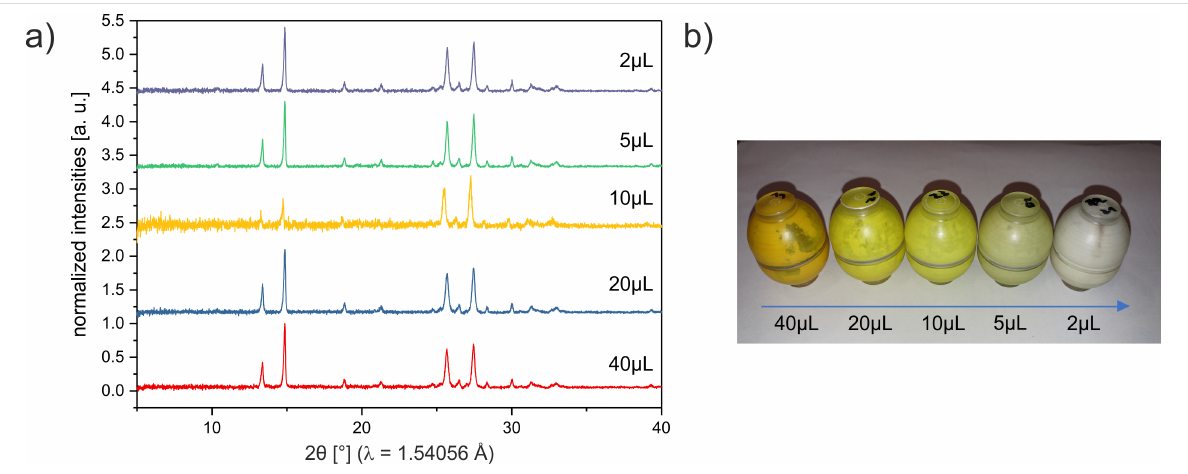
Figure 2: a) XRPD pattern of ( p -fluorobenzylidene)malonodinitrile ( 3a ) direct after the synthesis with different amounts of catalyst. b) Color change of the product 3a after the synthesis with different amounts of catalyst. The amount is reduced in the direction of the arrow.